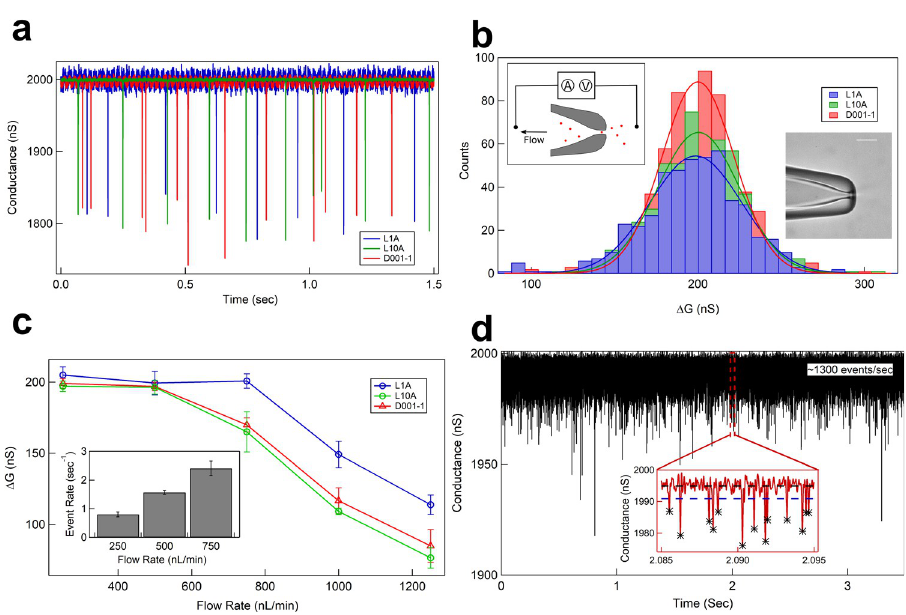
Fig 4. High throughput detection of model cells using lab amplifiers. a The plot shows 1.5 sec time series of open pore conductance baseline and the translocation events of 4.98 μ m beads translocating through a 6.8 μ m micropore device as measured using the L1A (blue), L10A (green) and D001-1 (red) amplifiers. Measurement was done at constant fluid flow of 500 nL/min. b Δ G histograms of detection events measured from the three different amplifiers are shown. Inset-left shows the schematic of the micropore experiment where the fluid flow is generated by a syringe pump and pore current across the micropore is measured by the amplifier. Inset-right shows optical microscope image of a typical micropore fabricated from a glass capillary. c Shows the mean signal ( Δ G) of the translocation events as a function of fluid flow rates measured using different amplifiers. The inset shows the change in event rates for different flow rates for L1A amplifier. d Demonstrates typical detection throughput of our lab amplifier (L10A). 4.06 μ m beads were detected through the same 6.8 μ m micropore device at a fluid flow of 50 μ L/min with the average event rate of 1308.4 particles/sec. The inset shows a 10 ms zoom of the times series and the detected events are marked by black stars. The baseline and the detection thresholds are shown by black and blue dashed lines, respectively. Online version in